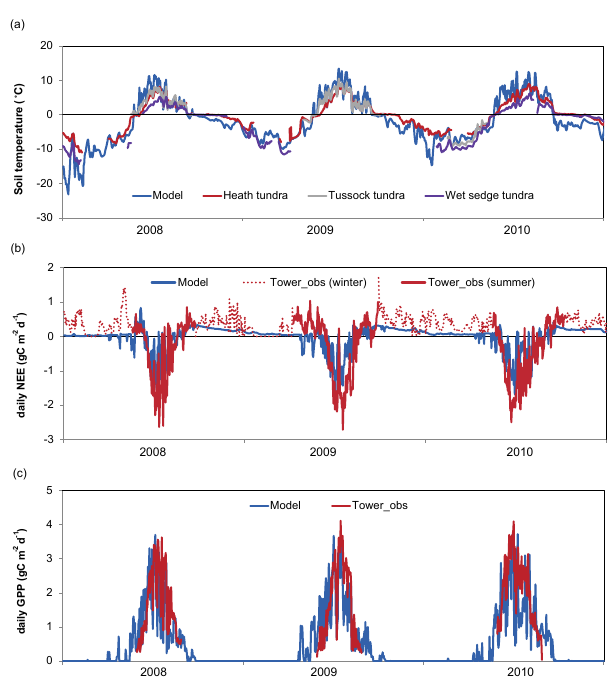
Figure 2. Comparisons of model-simulated (a) soil temperature at different depths (6, 16, 29, and 55cm) and carbon fluxes ( b : NEE; c : GPP) and tower measurements at a mature boreal forest site in Manitoba, Canada, over a 3-year (2002–2004) daily record. ical equation (Eq. 2). Based on Eq. (2), the modeled SCE will never approach 100 %, while the satellite data